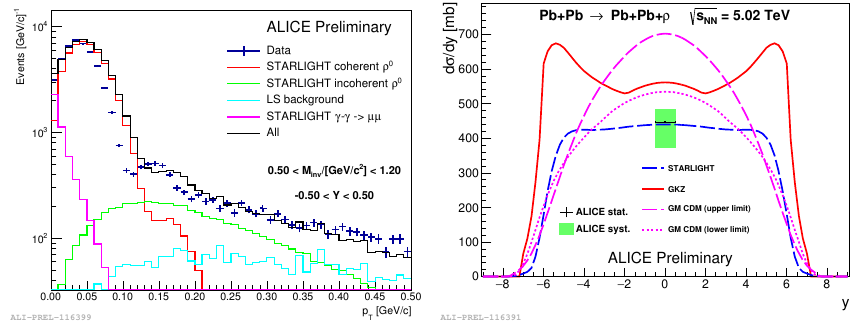
Figure 10. The two-pion transverse momentum distribution around the ρ 0 mass fitted with coherent and incoherent ρ 0 templates (left) and coherent di ff erential cross section of ρ 0 photoproduction (right) measured by ALICE in ultra-peripheral Pb–Pb collisions at